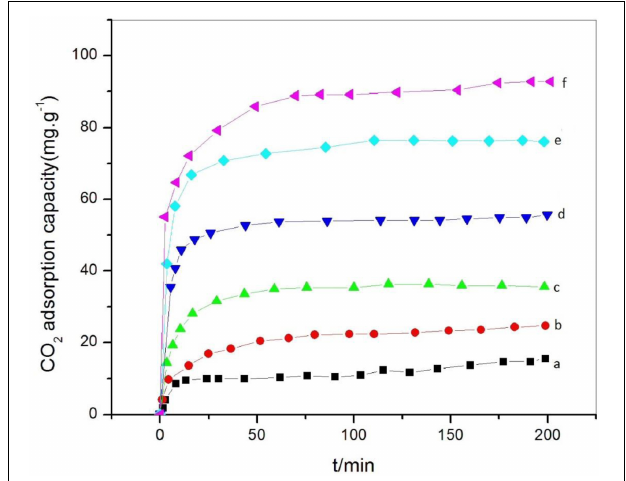
FIGURE 9 | CO 2 adsorption capacity of MMO-PEI-60 at 70 ◦ C and in partial pressures of (a) 7; (b) 25; (c) 50; (d) 70; (e) 80 and (f) 90 kPa.